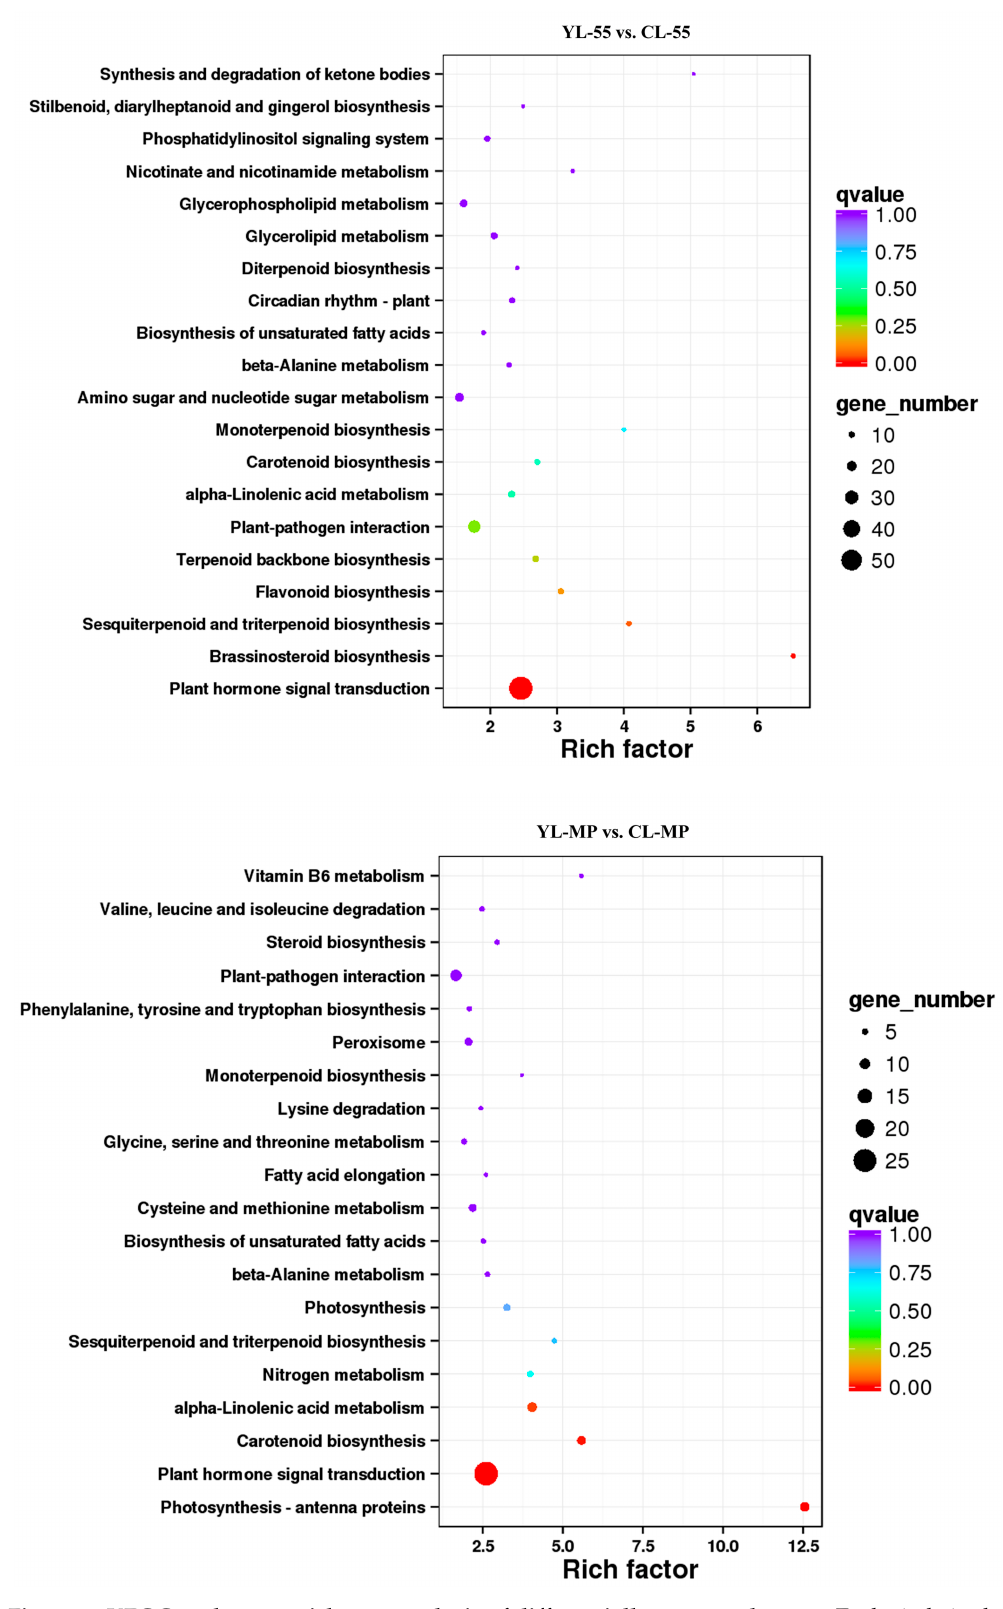
Figure 6. KEGG pathway enrichment analysis of di ff erentially expressed genes. Each circle in the figure represents a metabolic pathway of KEGG. The ordinate indicates the name of the metabolic pathway. The abscissa represents the enrichment factor. Phenylpropanoid biosynthesis (ko00940) and